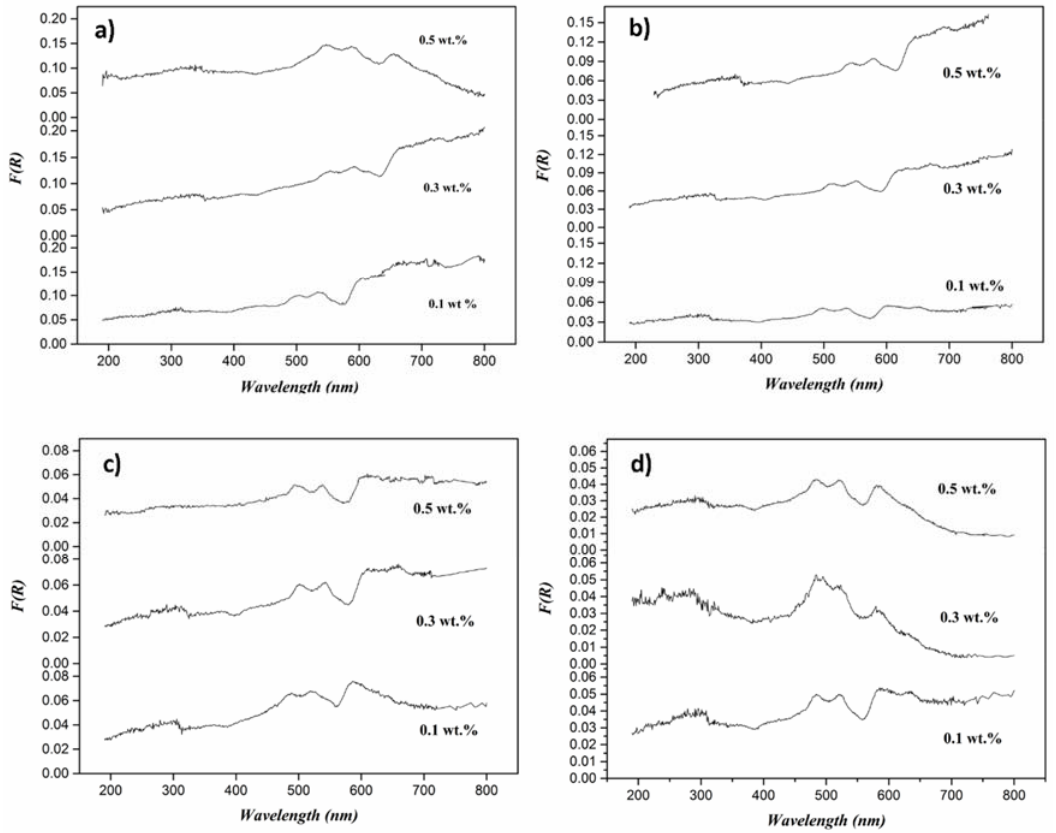
Figure 8. Di ff use reflectance UV–Vis spectra of PVA films with self-assembled chitosan-AuNPs / Figure 8. Diffuse reflectance UV–Vis spectra of PVA films with self ‐ assembled chitosan ‐ SWCNT-COOH nanostructures at the di ff erent SWCNT-COOH concentrations as a function of the AuNPs/SWCNT ‐ COOH nanostructures at the different SWCNT ‐ COOH concentrations as a function di ff erent HAuCl 4 · 3H 2 O concentrations: ( a ) 0.4, ( b ) 0.7, ( c ) 1.0 and ( d ) 1.3 of the different HAuCl 4 ∙ 3H 2 O concentrations: ( a ) 0.4, ( b ) 0.7, ( c ) 1.0 and ( d ) 1.3 mM.